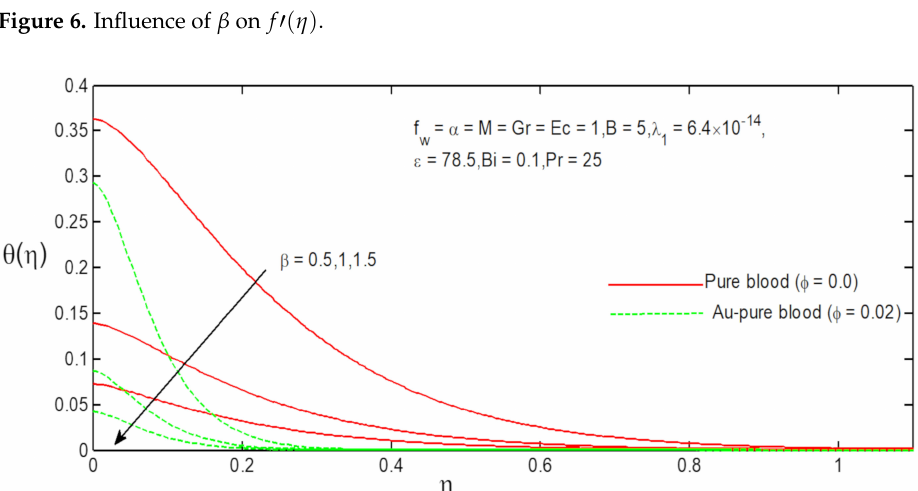
Figure 7. Influence of β on θ ( η )